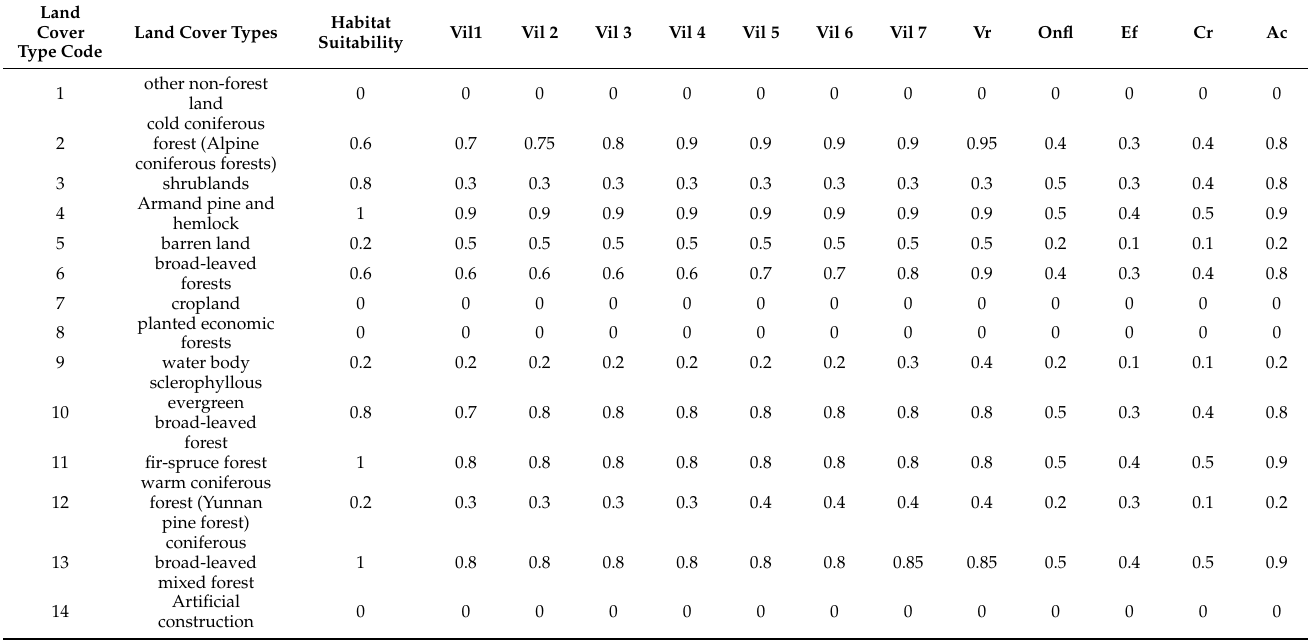
Table 6. Sensitivity of land cover types to each threat factor. (Vil1 = Village I, Vil2 = Village II, Vil3 = Village III, Vil4 = Village IV, Vil5 = Village V, Vil6 = Village VI, Vil7 = Village VII, Vr = Village road, Onfl = Other non-forestry land, Ef = Economic forest, Cr = Cropland, Ac = Artificial construction.).